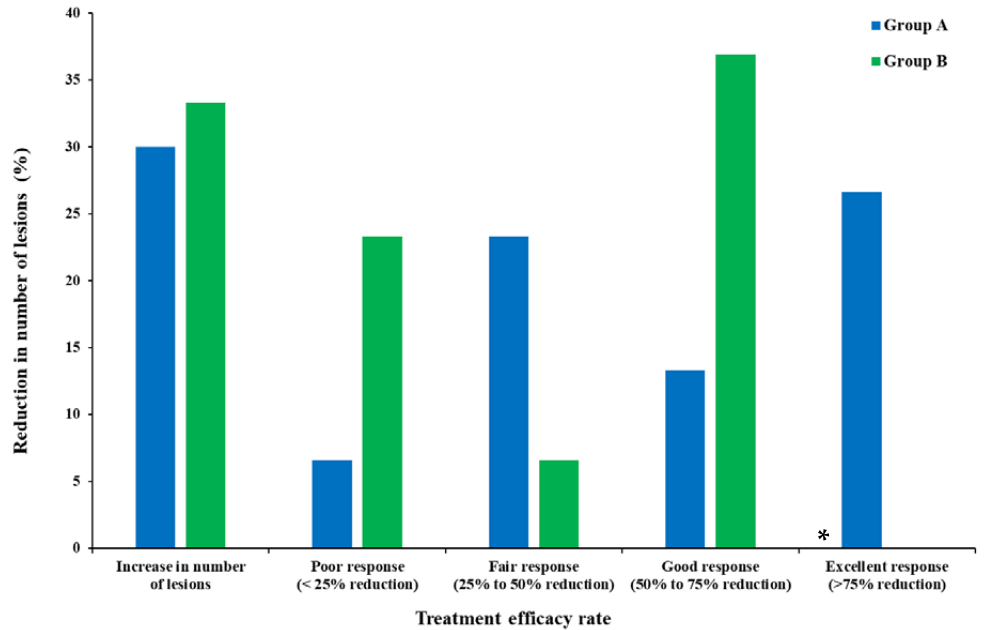
Figure 6. Treatment efficacy based on the reduction in number of lesions. * The Excellent response percentage in group B was reported to be 0%. (Group A: Niosomal ERY, Group B: combination of ERY and zinc acetate).